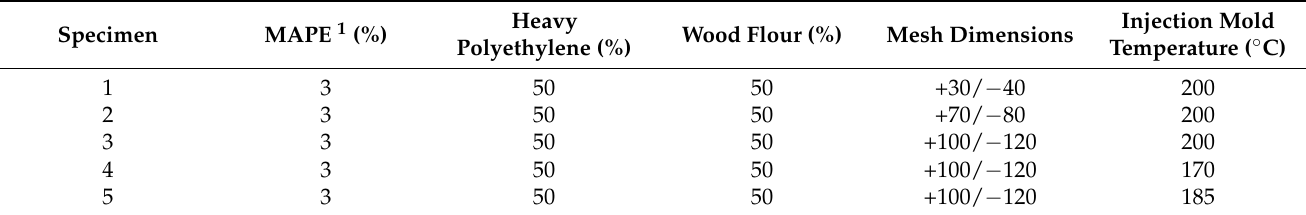
Table 1. The percentage of composite components and injection mold temperature for specimens.